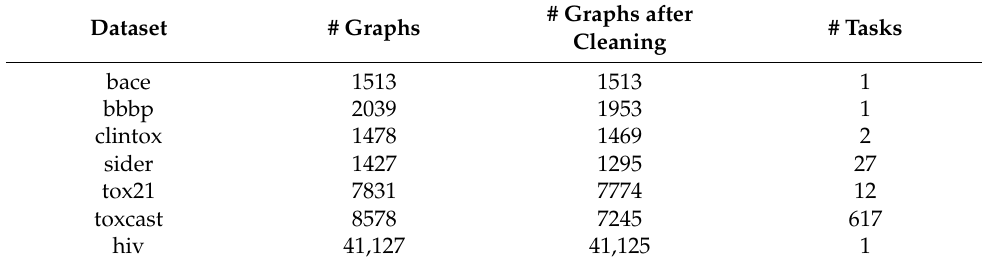
Table A2. Dataset